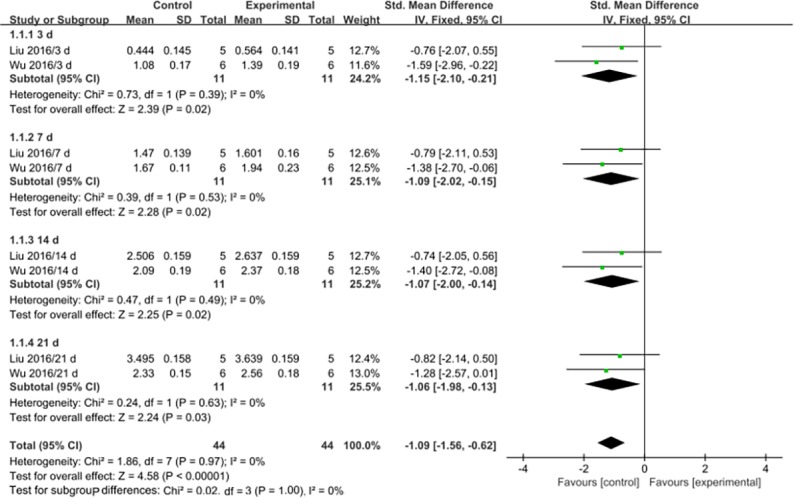
Forest plots showing the effects of MSCs on GSH levels.Control: PQ group; Experimental: MSC treatment group; CI: confidence interval; IV: independent variable; SD: standard deviation.